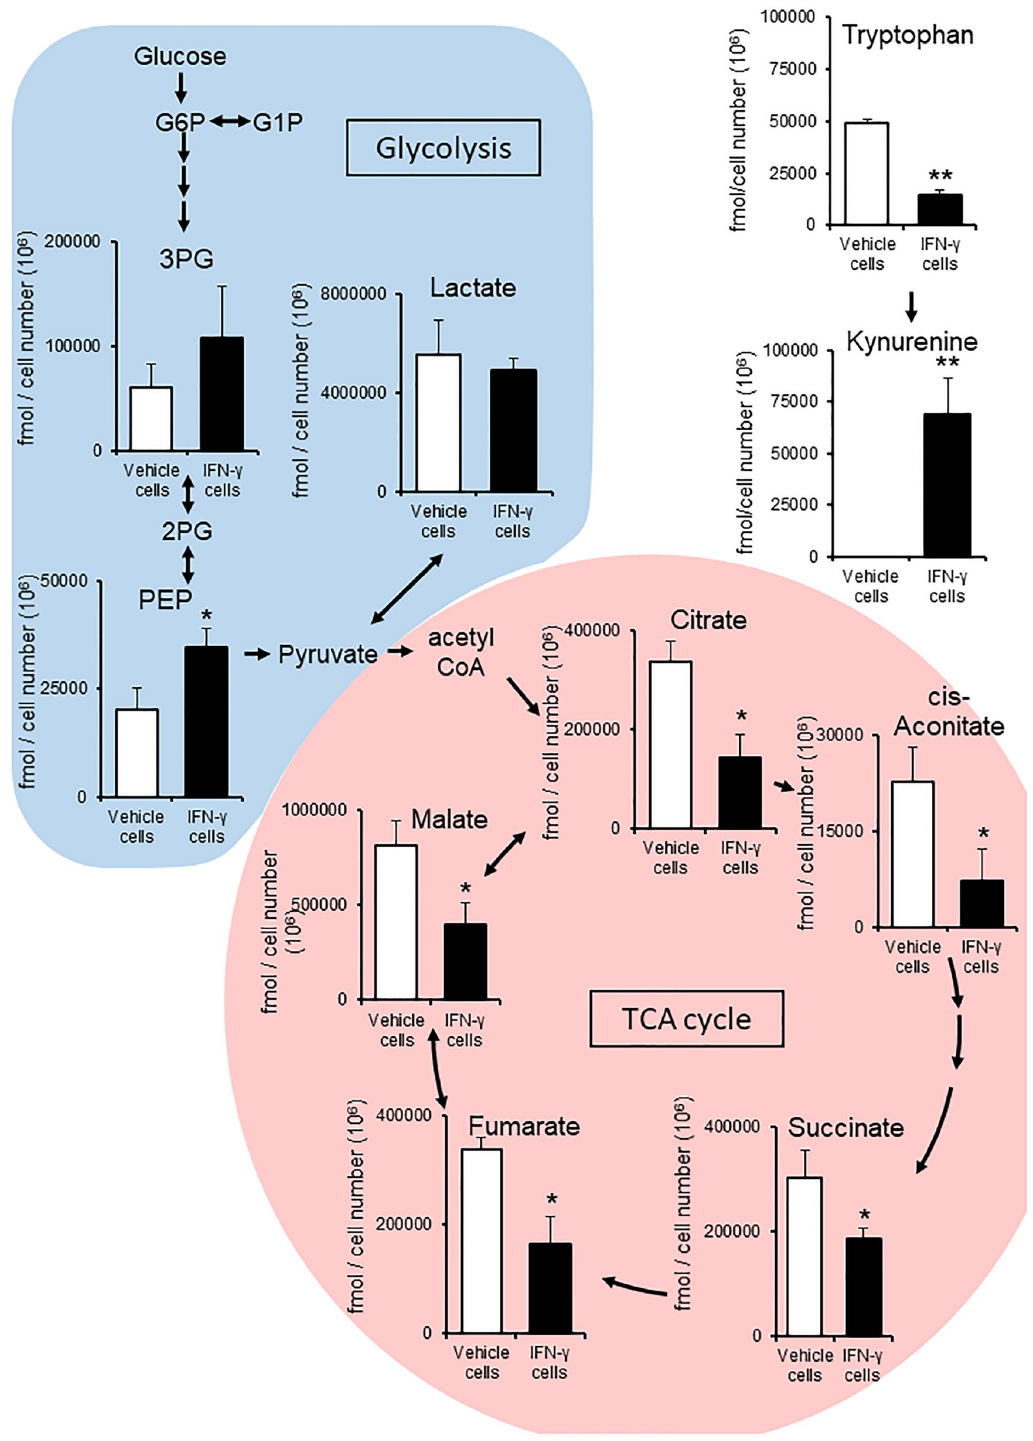
Fig 3. Metabolome data map of metabolites involved in the glycolysis, TCA cycle, and tryptophan catabolism pathways, as detected in D3H2LN cells treated with or without IFN- γ . (A) After IFN- γ treatment, there was a significant difference in the amount of components related to glycolysis and the TCA cycle; PEP ( P = 0.041), citrate ( P = 0.011), cis-aconitate ( P = 0.040), succinate ( P = 0.042), fumarate ( P = 0.011), and malate ( P = 0.028). (B) The amounts of tryptophan ( P = 6.4E -5 ) and kynurenine ( P = 0.010), components of tryptophan catabolism. Kynurenine increased significantly in the presence of IFN- γ . Columns, average concentration (fmol/cell number (10 6 )); bars, S.D. (n = 3). � P < 0.05, �� P < 0.01 (Student’s t -test). PEP, phosphoenolpyruvate. All experiments were performed using three biological